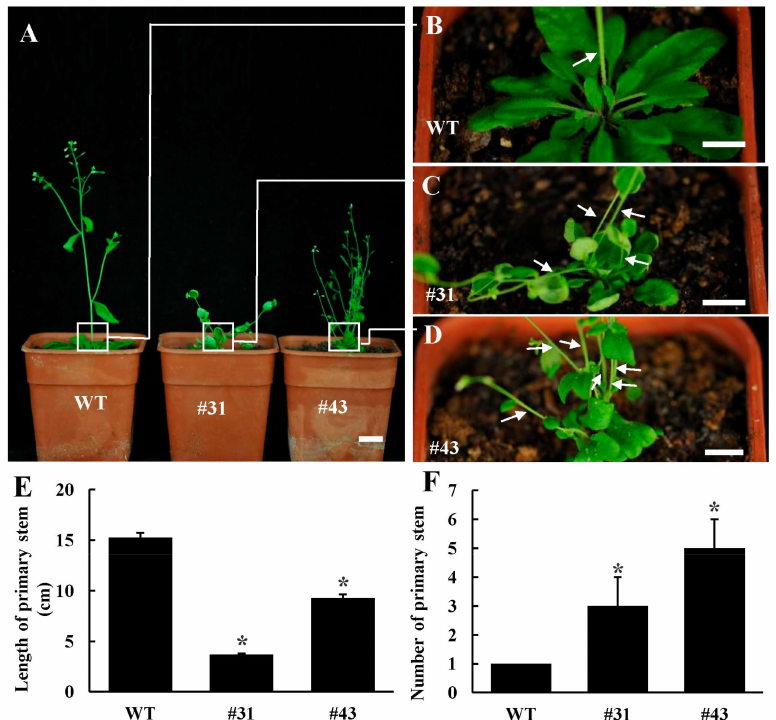
Figure 5. Overexpression of PtoWUSa led to compromise of shoot branching in Arabidopsis . ( A ) Aboveground phenotypes of WT and PtoWUSa -overexpressing Arabidopsis plants. ( B – D ) Close-up views of shoot branches in the squares of the corresponding plants in ( A ). Arrows pointed to shoot branches. ( E – F ) Comparison of length of primary stem ( E ) and number of primary stem ( F ) between WT and transgenic plants. * indicated the di ff erence between Ctrl and each transgenic line at p < 0.05 level, respectively. Scale bars: ( A ) = 2 cm; ( B – D ) = 1